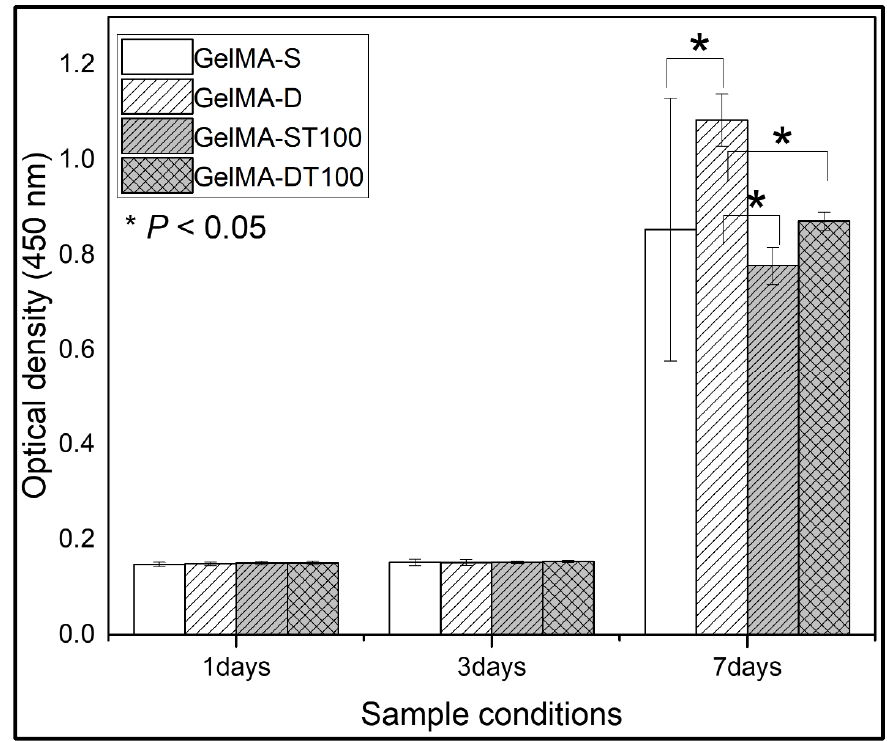
Figure 4. The proliferation of cells measured by CCK8 assays (WST) on days 1, 3, and 7. (Data are presented as mean ± SD, n = 3, * p < 0.05).